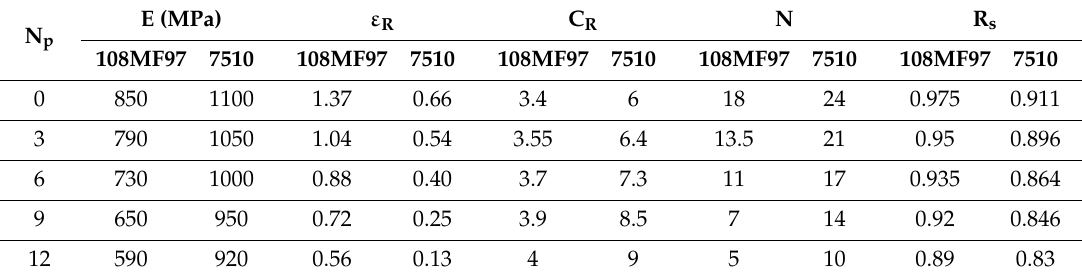
Figure 5. Reprocessing parameters ( a ) C R , ( b ) N , and ( c ) R s for 108MF97 and 7510. Table 1. Reprocessing sensitive